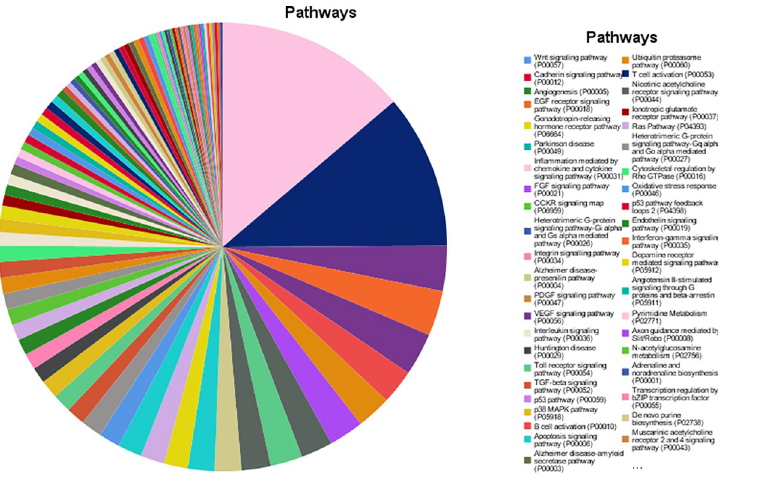
Fig 6. Results of pathway